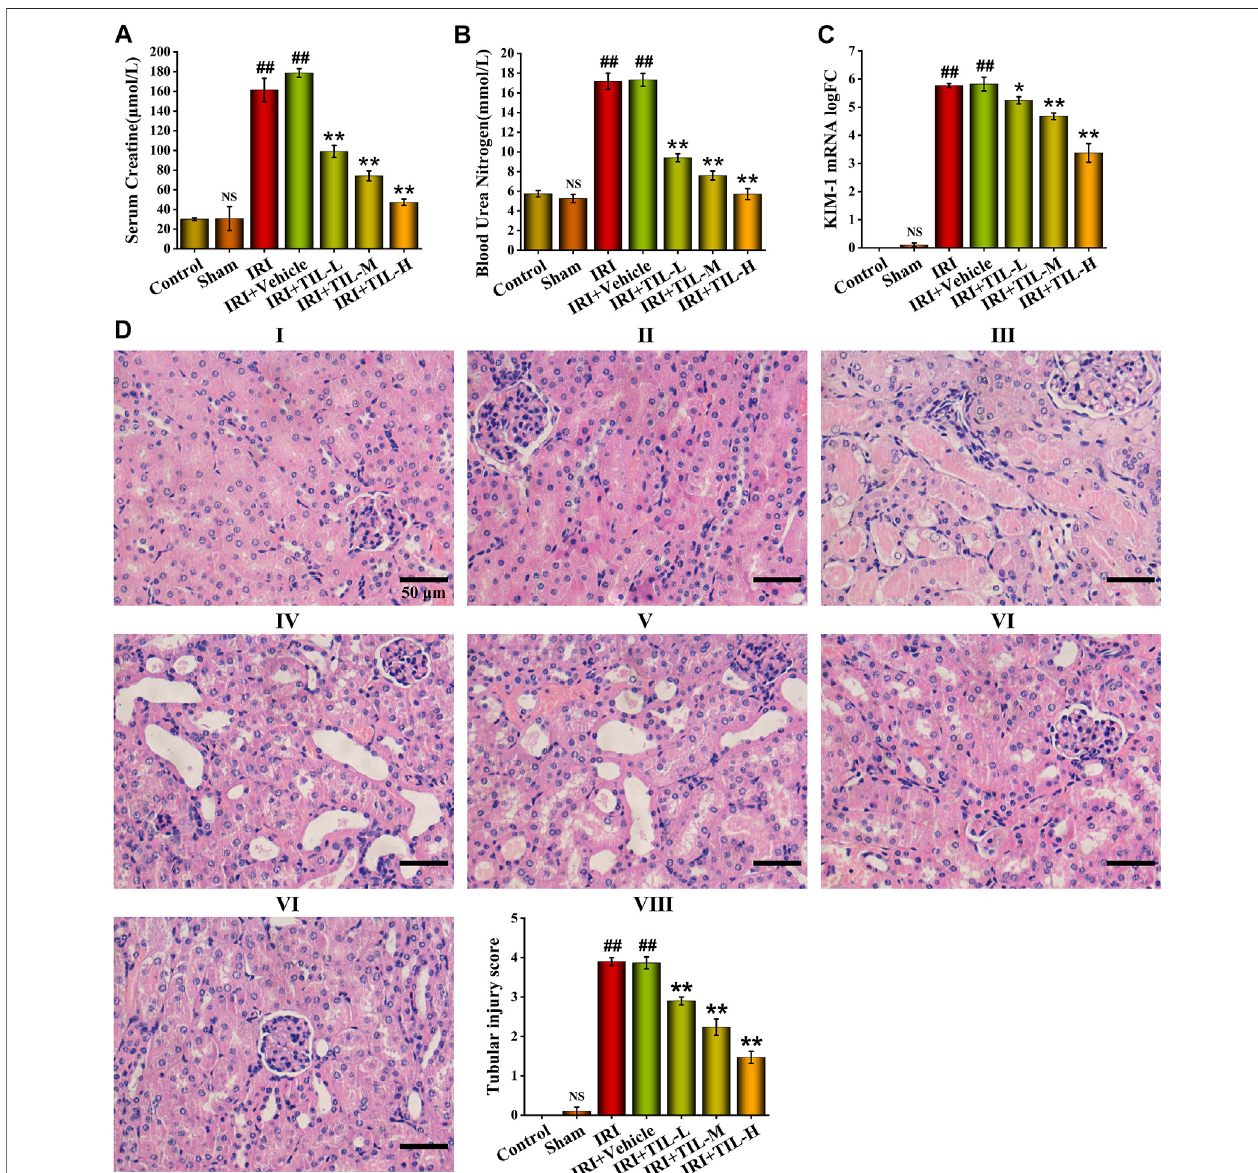
FIGURE 2 | Tilianin improved kidney function of I/R-induced AKI mice. (A,B) Quantitative analysis of Scr and BUN in different groups, as indicated. (C) Quantitative analysis of KIM-1 mRNA levels determined by qRT-PCR in different groups, as indicated. (D) H&E staining images under the magni fi cations of 400× showed the extent of tubularinjury,andpathologicalscorewasquanti fi edbasedonthestandarddescribedin “ MethodsandMaterials . ” Scalebar,50 μ m( Ⅰ :controlgroup; Ⅱ :shamgroup; Ⅲ :IRI group; Ⅳ :IRI+vehiclegroup; Ⅴ : IRI+TIL-L group; Ⅵ : IRI+TIL-Mgroup; Ⅶ : IRI+TIL-Hgroup; Ⅷ : quantitative analysisoftubular injuryscores). IRI:ischemia – reperfusion injury group; IRI+TIL-L: IRI mice treated with tilianin 5 mg/kg group; IRI+TIL-M: IRI mice treated with tilianin 10 mg/kg group; and IRI+TIL-H: IRI mice treated with tilianin 15 mg/kg group. n = 3 per group. All data are shown as mean ± SD. ## p < 0.01 versus control ; NS P > 0.05 versus control ; *p < 0.05, **p < 0.01 versus